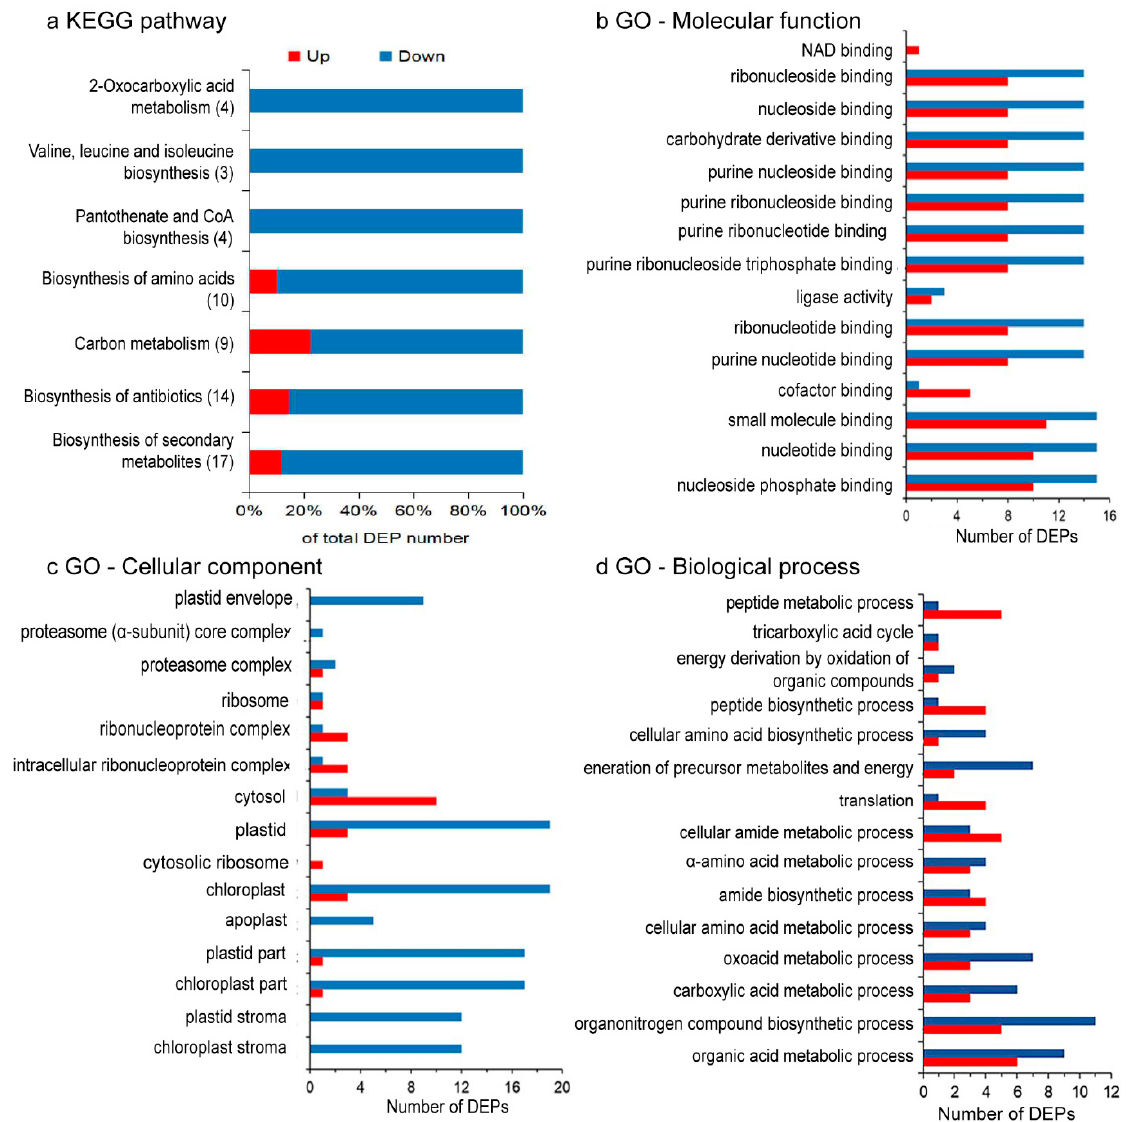
Figure 3. Classification of the differentially expressed proteins (DEPs) in Chromochloris zofingiensis with or without glucose. The red and blue colors represent the upregulated and downregulated proteins, respectively. ( a ) Distribution of the DEPs from the crucial KEGG pathways that were significantly enriched; thus, with a p -value < 0.05 under the glucose addition condition. Changes are denoted as the percentage of proteins in each pathway. ( b – d ) GO classification of DEPs with p < 0.01.